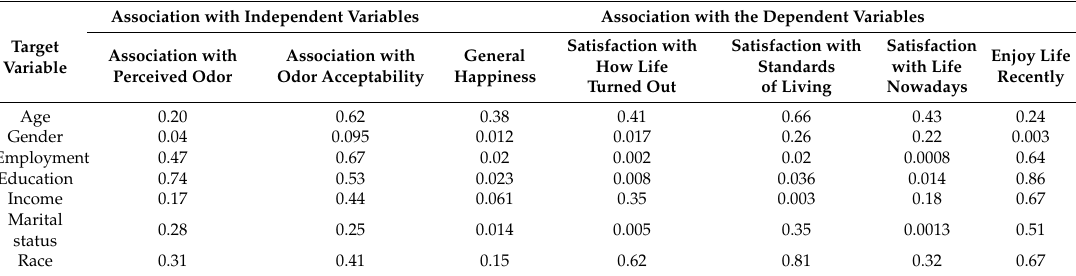
Table 6. Association between target variables and both dependent and independent